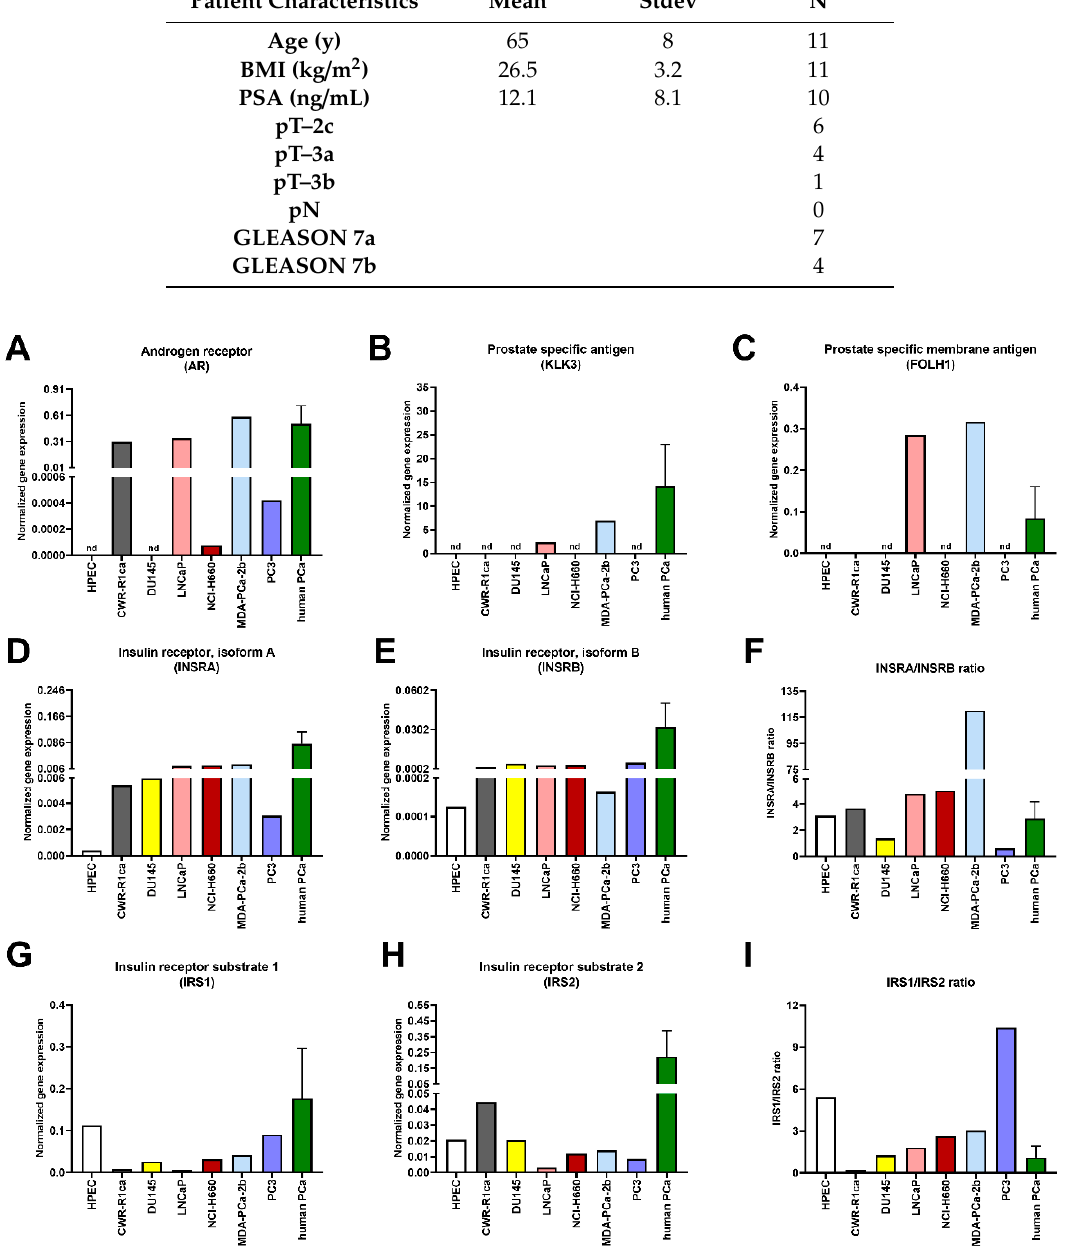
Figure 1. Transcript levels of hormone receptors and downstream substrates in prostate-cancer cell lines and in human prostate-cancer tissue. Transcript levels of indicated genes measured using real-time PCR. ( A ) AR , ( B ) KLK3 , ( C ) FOLH1 , ( D ) INSRA , ( E ) INSRB , ( F ) INSRA / INSRB ratio, ( G ) IRS1 , ( H ) IRS2 , ( I ) IRS1 / IRS2 ratio. PCa: prostate cancer, HPEC: parental primary prostate cells, CWR-R1ca: xenograft PCa cells, DU145: brain metastasis PCa cells, LNCaP: lymph-node metastasis PCa cells, NCI-H660: lymph-node metastasis PCa cells, MDA-PCa-2b: bone metastasis PCa cells, PC3: bone metastasis PCa cells, nd: not detected. For human PCa samples, data shown as pooled samples: mean ± standard deviation ( n =